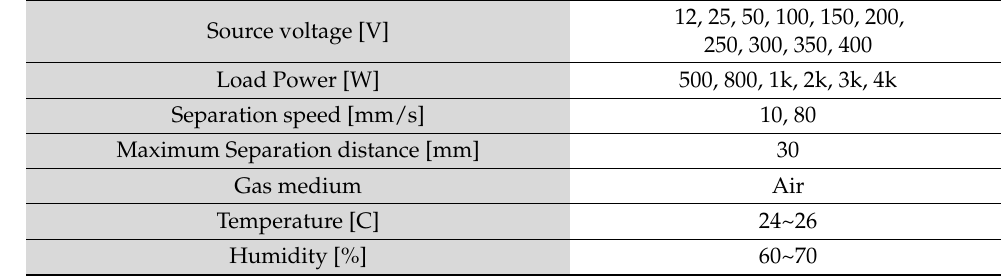
Table 1. Experimental